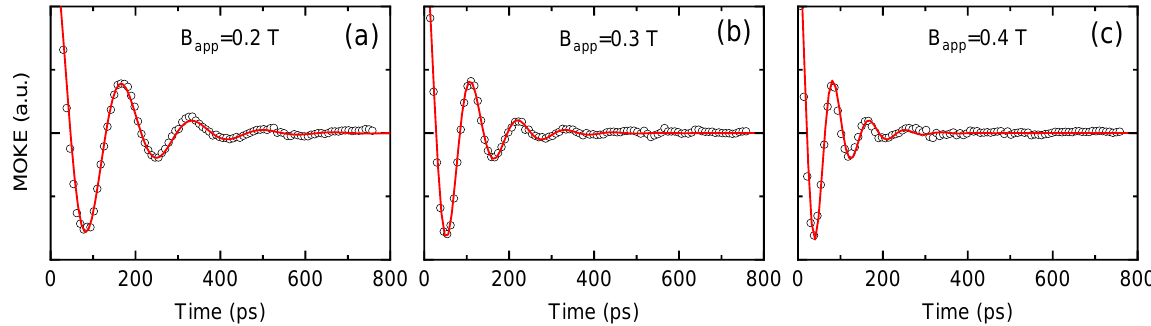
Figure A1. The B app dependence on α eff . The precessional motion in the Gd 24 Co 76 alloys with B app of ( a ) 0.2, ( b ) 0.3, and ( c ) 0.4 T along the x -direction. The black circles are obtained by subtracting the demagnetization background from the raw data of TRMOKE. The red lines are fittings by damped cosine function of cos ( 2 π ft ) × exp ( − t / τ ) . The fitted f values are 6.0, 8.9, and 11.8 GHz for ( a – c ), respectively. The fitted τ values are 120, 80, and 60 ps for ( a – c ),